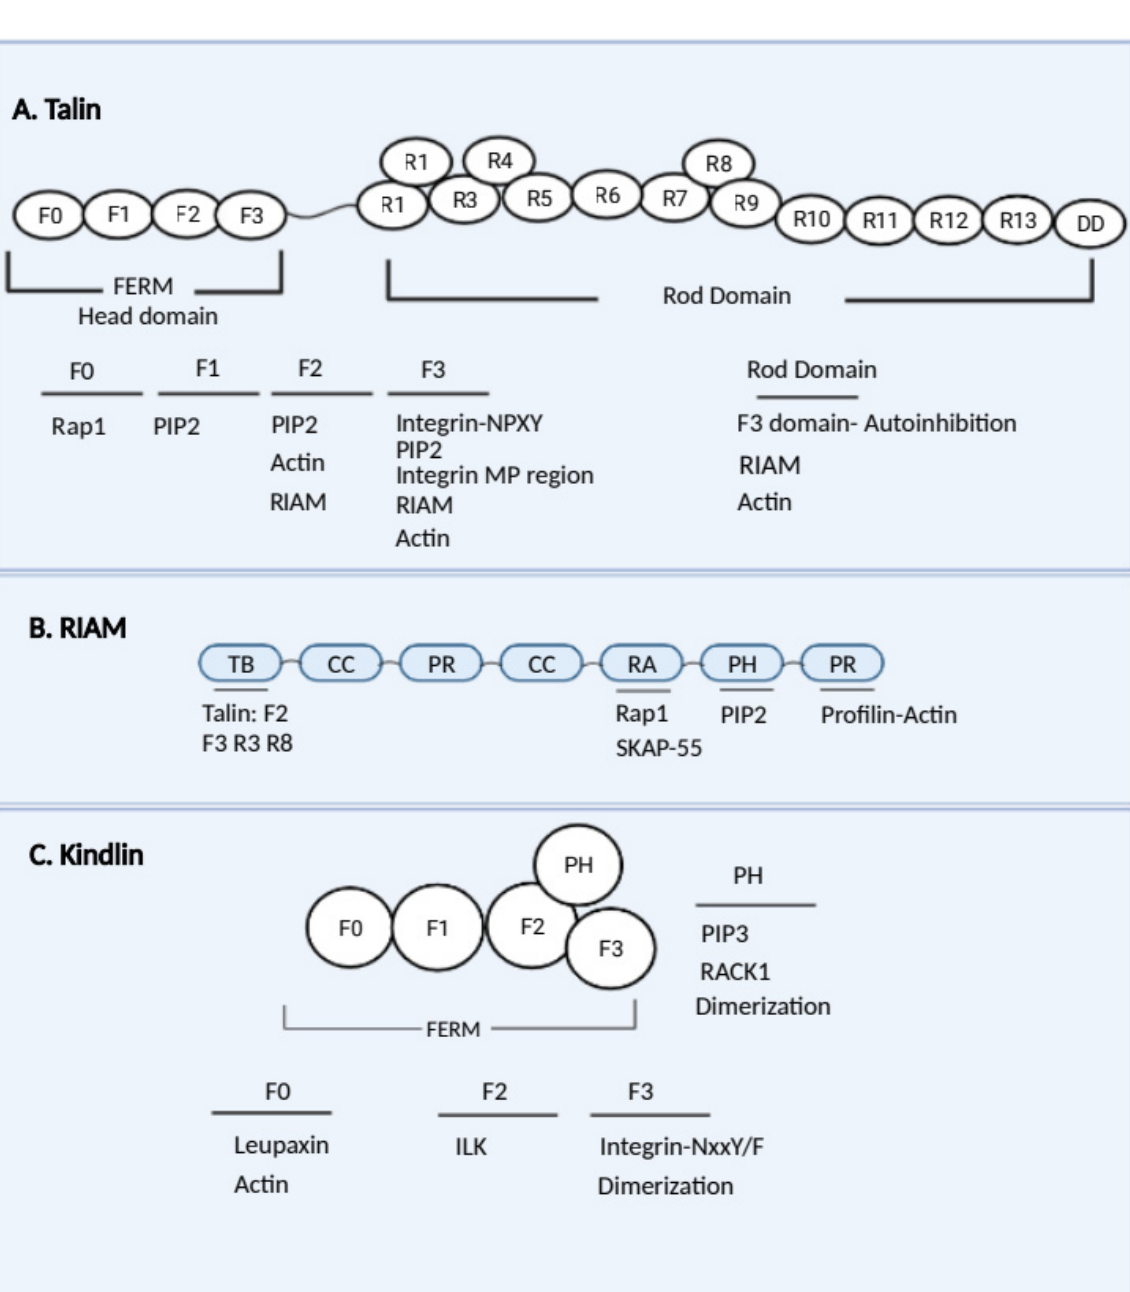
Figure 3. Schematics showing domains and binding proteins of talin ( A ), RIAM ( B ), and kindlin ( C ). Integrin-NPXY: Asn-Pro-x-Tyr motifs of the β -integrin tail; Integrin MP region: membrane-proximal region of the β -integrin tail; Integrin-NxxY/F: Asn-x-x-Tyr/Phe motifs of the β -integrin tail; PIP2: phosphatidylinositol 4,5-bisphosphate; PIP3: phosphatidylinositol-3,4,5-triphosphate; Profilin-Actin: 12 June